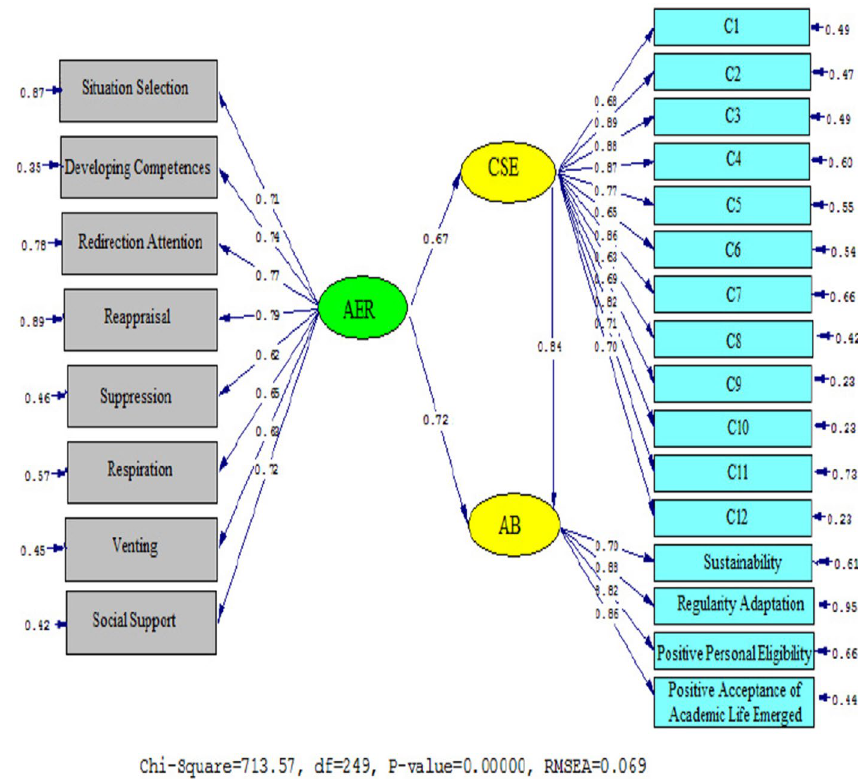
Fig. 2 Schematic representation of path coefficient values for the relationships between AER, CSA, and AB (model 1)